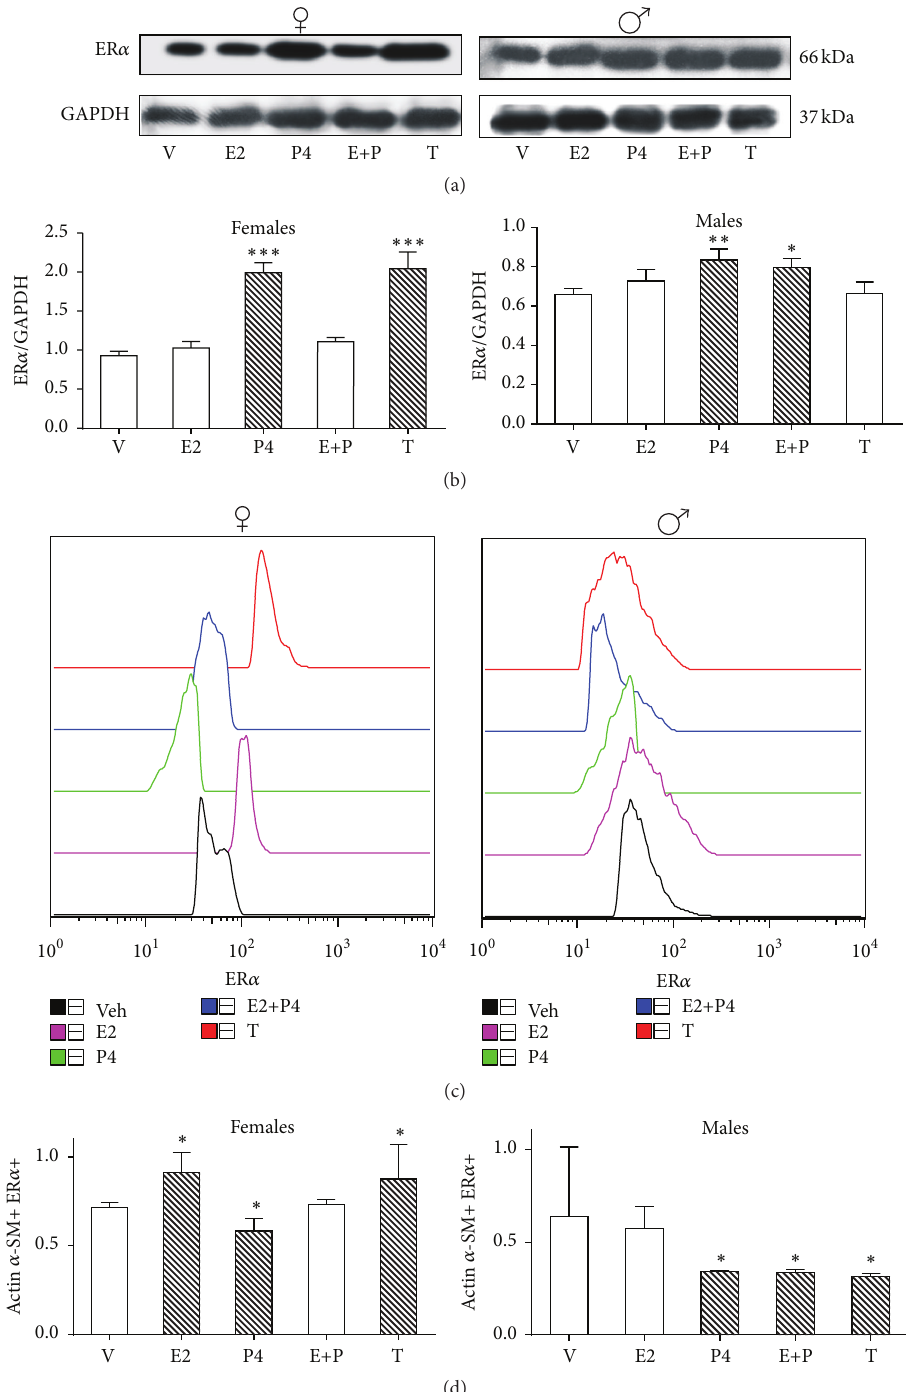
Figure 1: Regulation of ER 𝛼 protein content by sex hormones in airway smooth muscle (ASM) and airway smooth muscle cells (ASMC). ER 𝛼 protein content in ASM and ASMC of gonadectomized female and male rats treated with vehicle (v, corn oil), 17 𝛽 -estradiol (E2), progesterone (P4), 17 𝛽 -estradiol + progesterone (E + P), and testosterone propionate (T). (a) A representative assay of four Western blot experiments is shown. The protein antibody complex was detected by chemiluminescence. Blots were stripped and reprobed with GAPDH antibody to correct differences in the amount of total loaded protein. (b) Proteins detected by Western blot were quantified by densitometric analysis and corrected by GAPDH protein content. Results are expressed as mean ± SD, 𝑛 = 4 . ∗ 𝑝 < 0.05 compared with vehicle treatment, ∗∗ 𝑝 < 0.01 compared with vehicle treatment, and ∗∗∗ 𝑝 < 0.001 compared with vehicle treatment. (c) Flow cytometry histogram plots are based on forward scatter (FSC) and side scatter (SSC) gating for ASMC. This was validated using actin 𝛼 -smooth muscle and ER 𝛼 staining. A representative example of the gating strategy is shown. (d) Geometric mean fluorescence intensity (gMFI) for ER 𝛼 expression on ASMC. Results are expressed as mean ± SD, 𝑛 = 4 . ∗ 𝑝 < 0.05 compared with vehicle